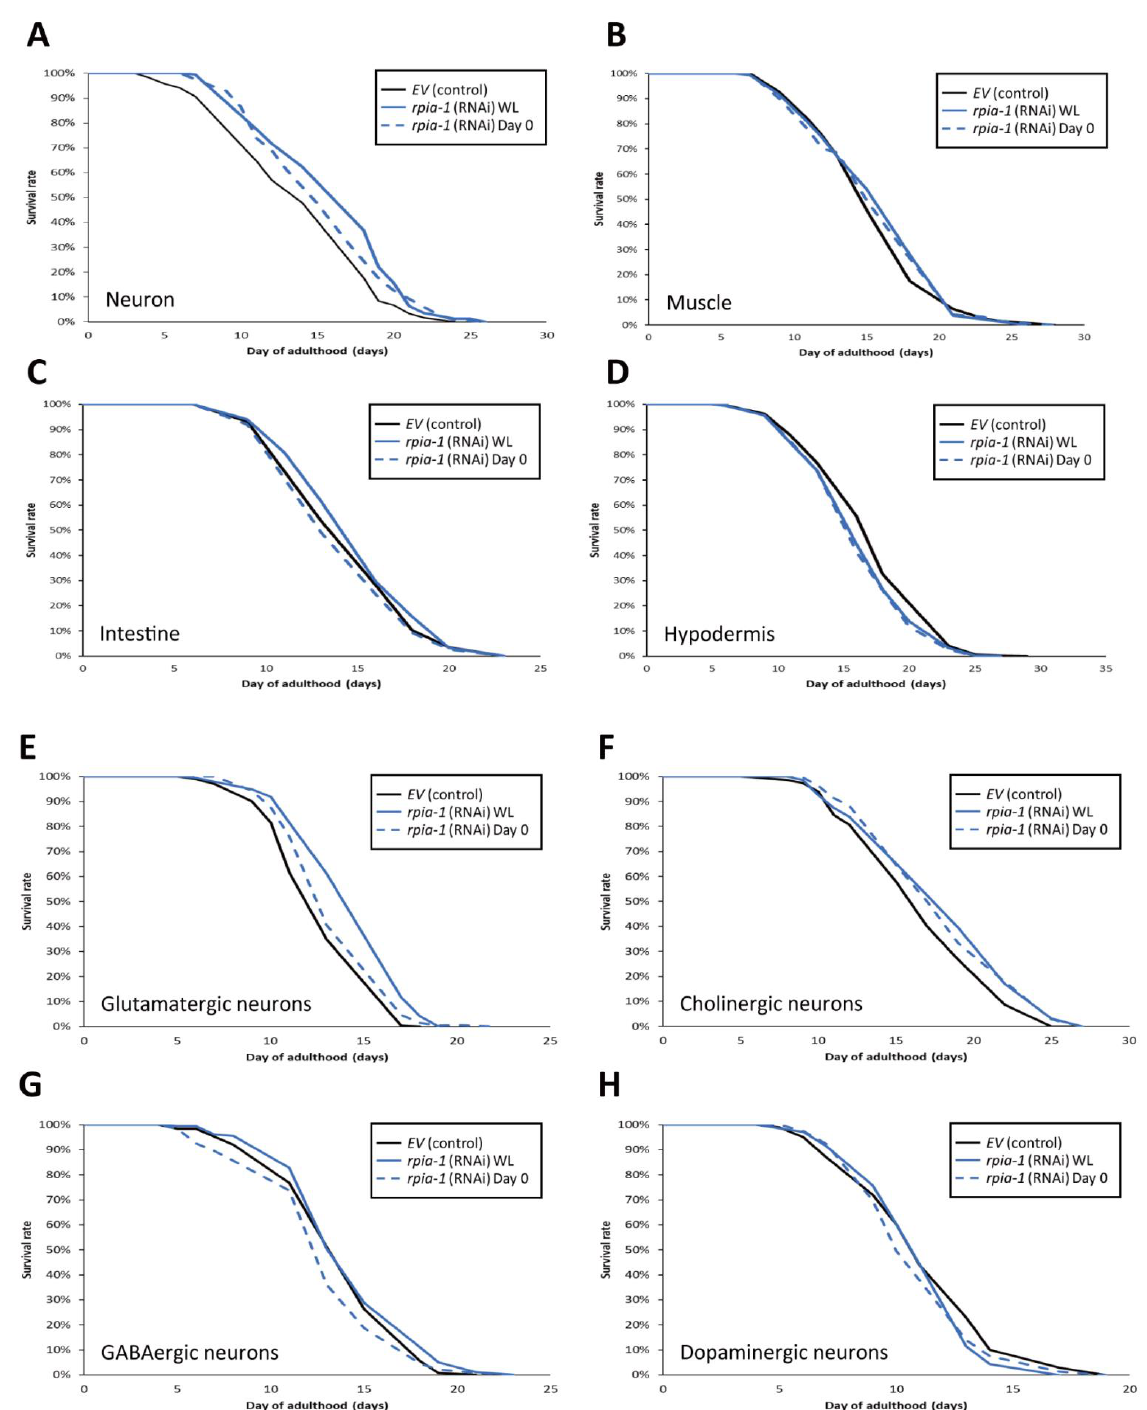
Figure 4. Knockdown of rpia-1 in glutamatergic or cholinergic neurons prolongs lifespan. In these lifespan experiments, all solid black lines represent control group, and blue lines rpia-1 knockdown groups. The solid blue lines indicate rpia-1 knockdown from embryonic stage (WL) and blue dashed lines from day 0 of adulthood. ( A ) Knockdown of rpia-1 in neurons starting at the embryonic (WL) and post-developmental (Day 0) stages extended the mean lifespan by 13.7% and 5.2%, respectively. ( B , C ) Knockdown of rpia-1 in muscle or intestine showed no effects on lifespan independent of the time of knockdown initiation (since embryonic (WL) or post-developmental (Day 0) stages). ( D ) Knockdown of rpia-1 in hypodermis shortened the mean lifespan by 4.6% and 5.1% when initiated at the embryonic or post-developmental stages, respectively. ( E ) Knockdown of rpia-1